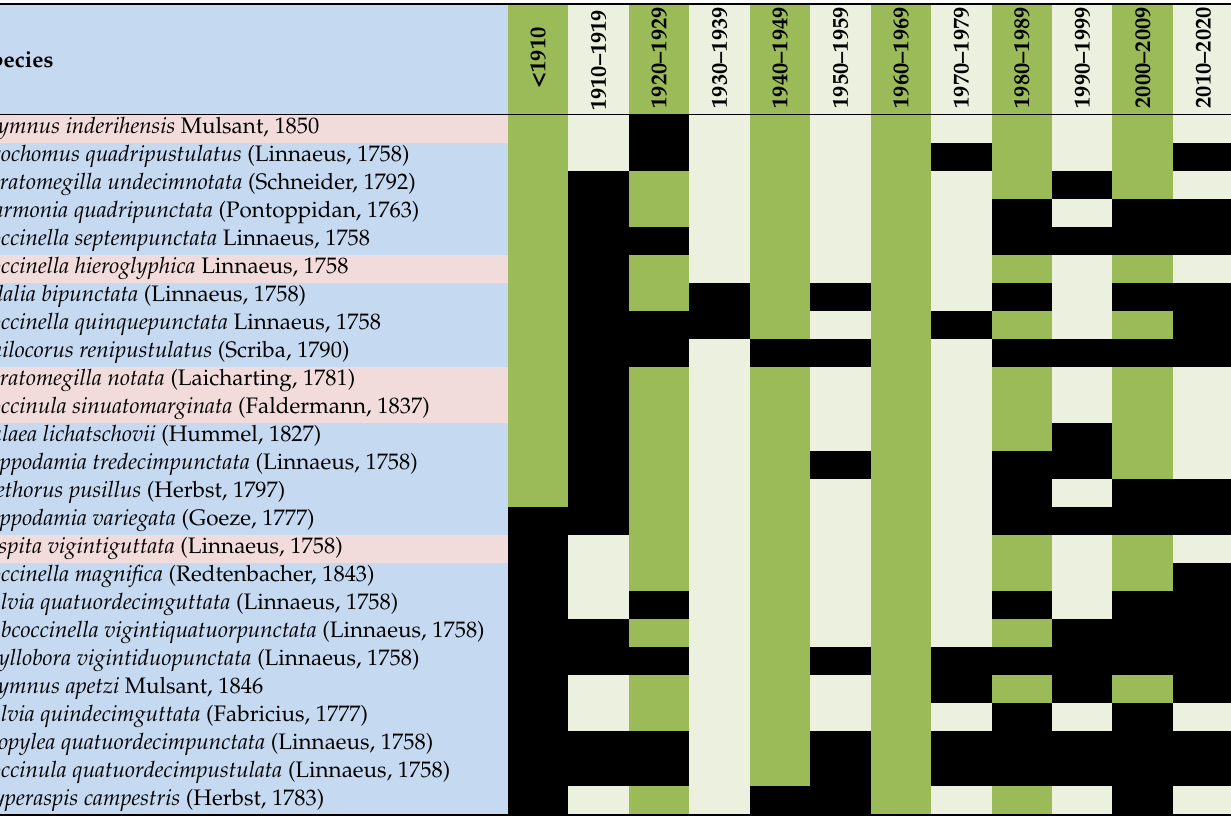
Table 1. Species recorded before 1930. The species are arranged in the reverse chronological order of their first records. The decades when the species was detected are shaded with black. The species detected before 1930 but not detected later are shaded with